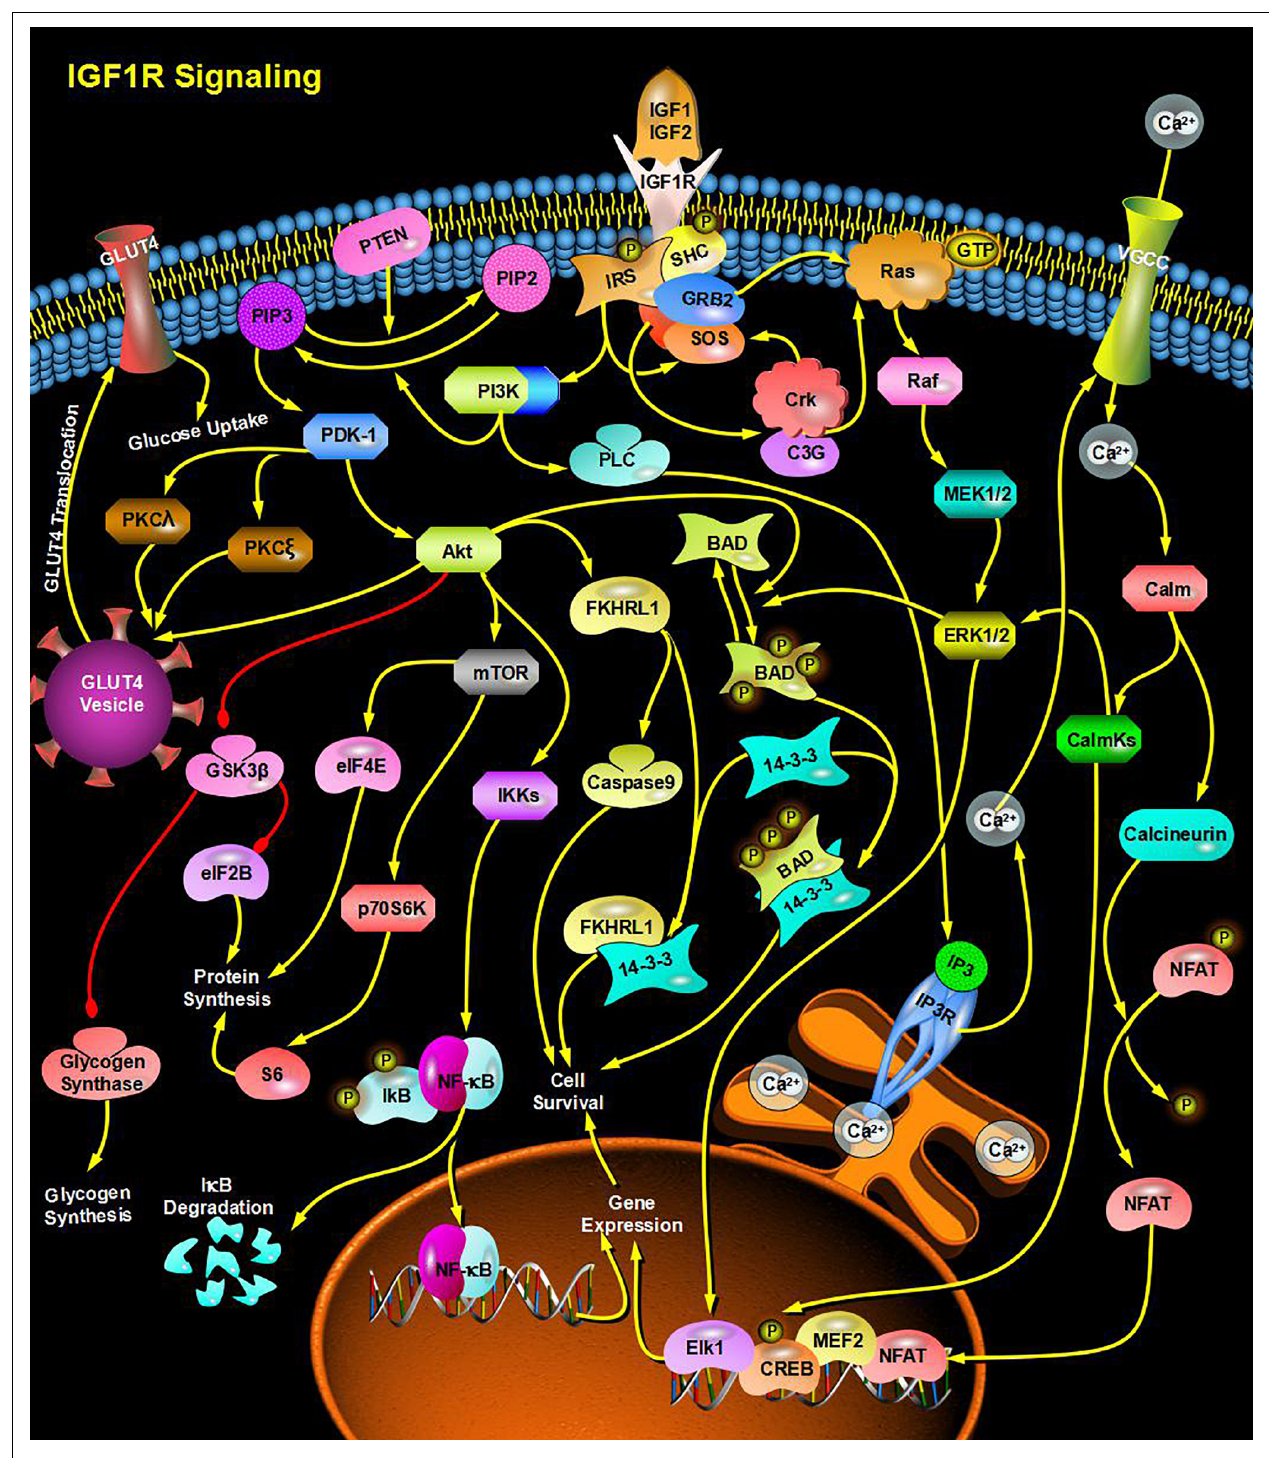
FIGURE 4 | miRNA-28-3p promotes cell proliferation and migration through the IGF signaling pathway and participates in the regulation of diabetes.